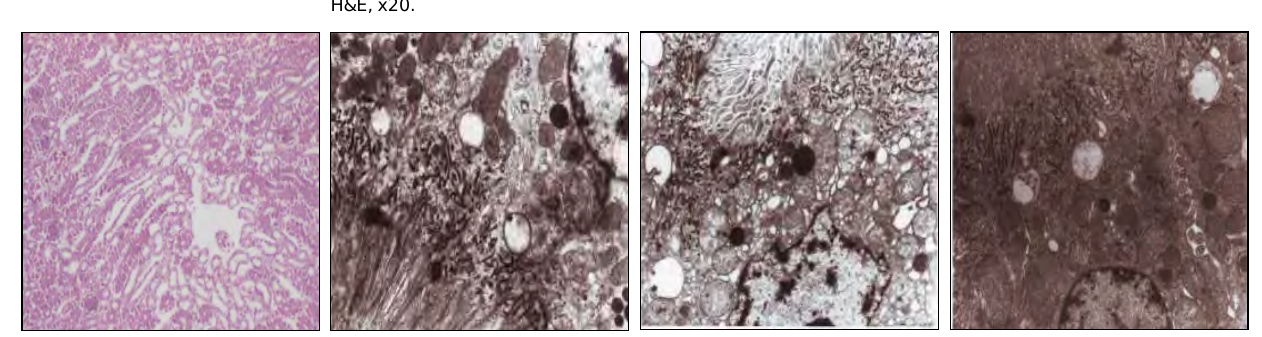
th Figure-12. Kidney of 5 day post rd Figure-11. Kidney of 3 day post treatment chicken showing mild treatment group showing tubular degeneration. H&E, x20. degeneration of tubular epithelial cells with haemorrhagic areas. H&E, x20.